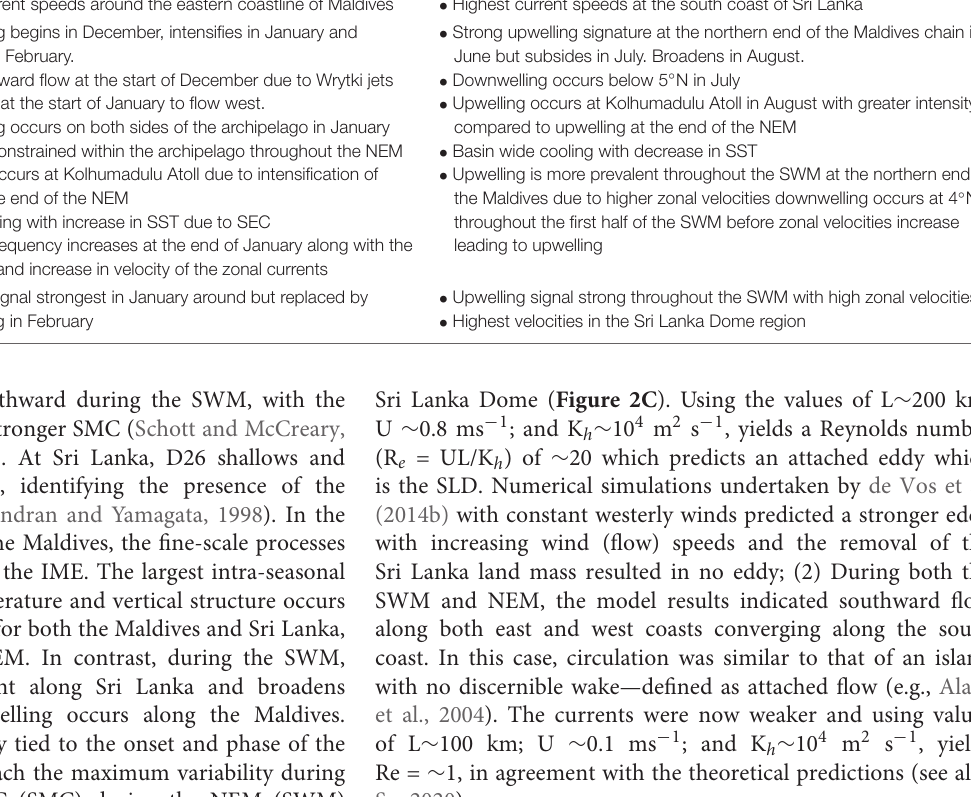
TABLE 2 | Summary of key findings on the IME processes around the Maldives and Sri Lanka. NEM SWM